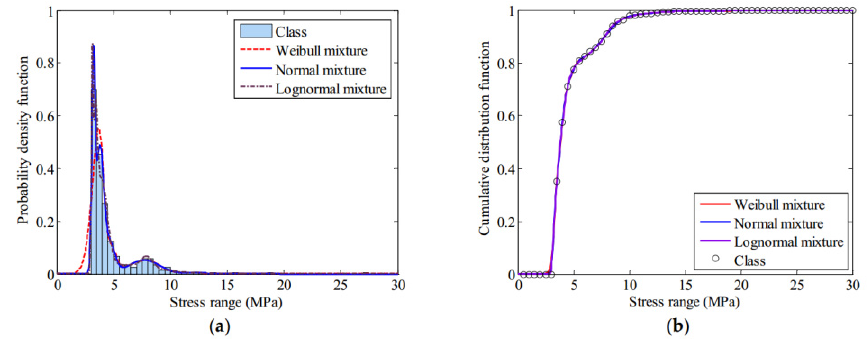
Figure 10. Distribution function of stress range: ( a ) finite mixture probability distribution function (PDF); ( b ) finite mixture umulative distribution function (CDF) [151] .